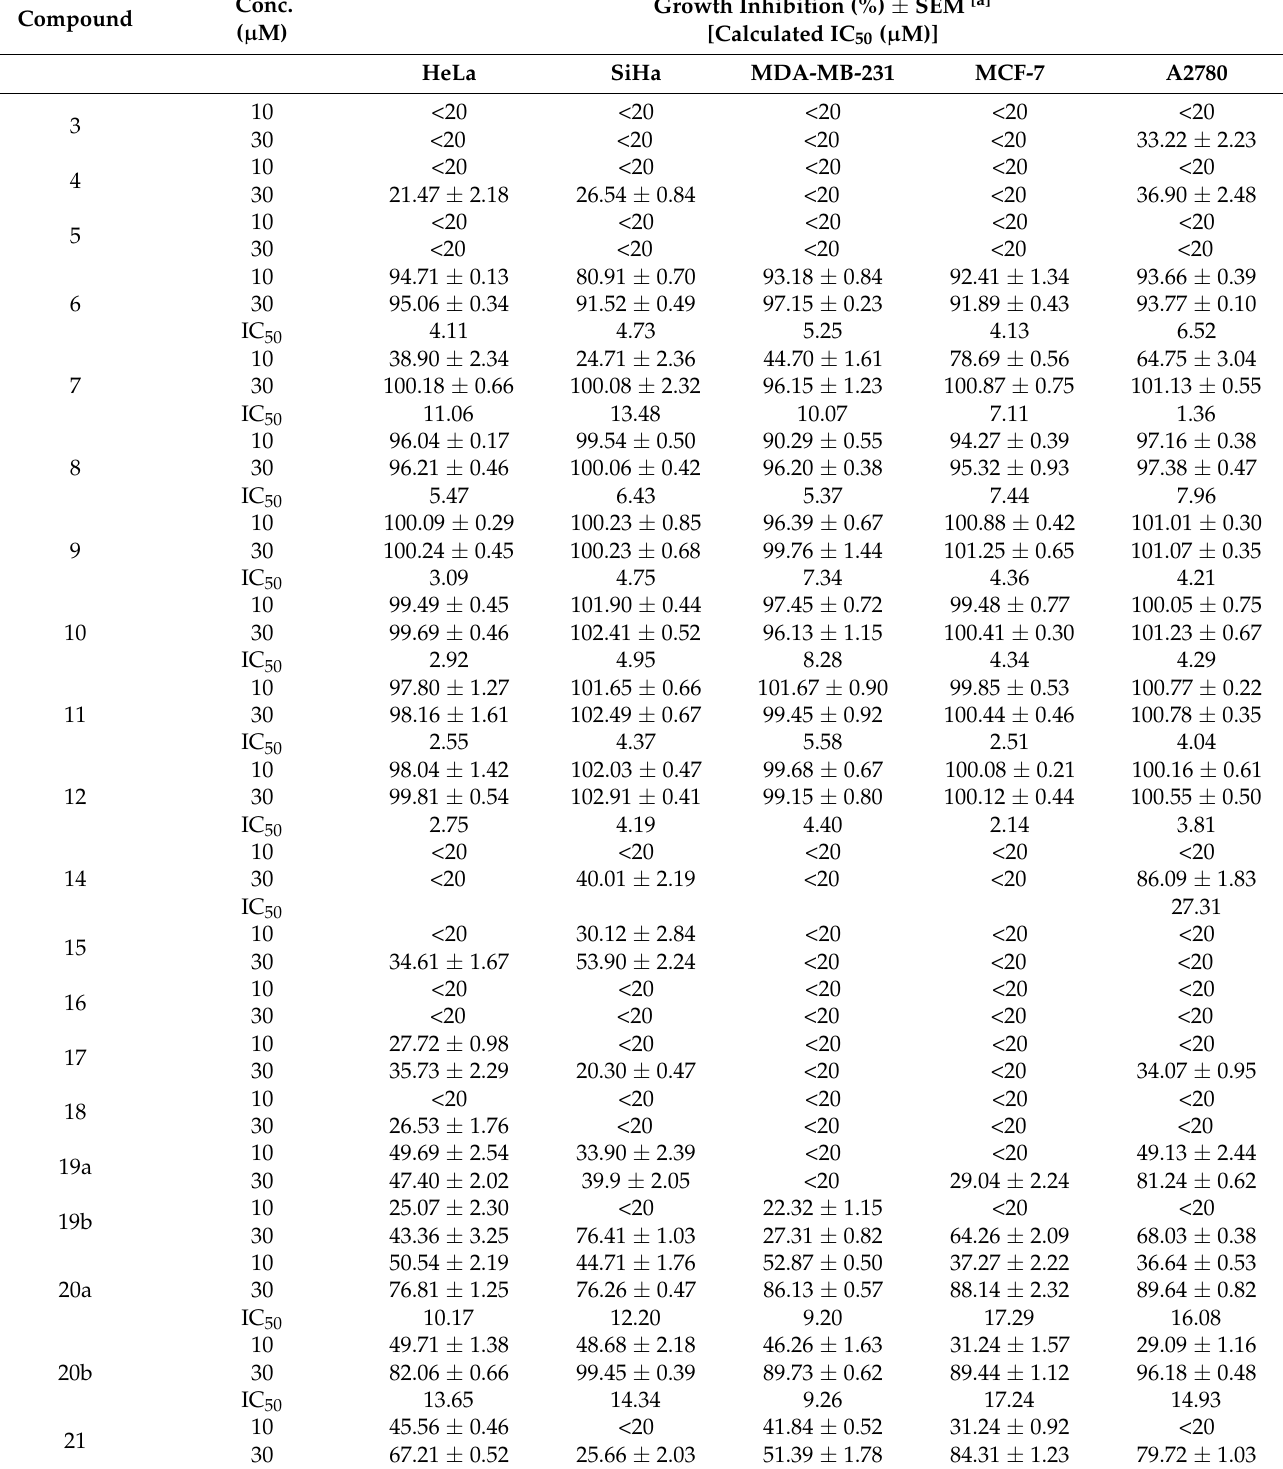
Table 4. Antiproliferative properties of the tested diterpene